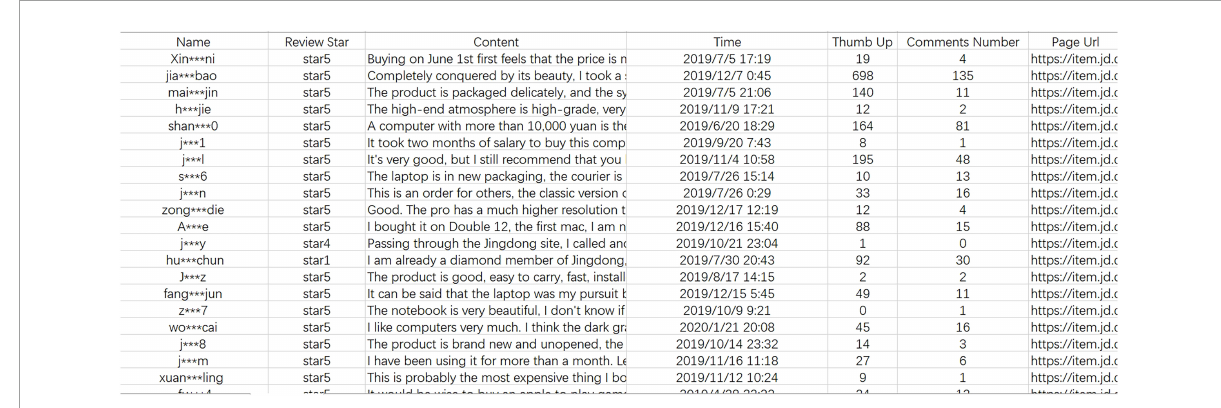
FIGURE1 Crawl results of online review data for four popular laptops on the JD.com (partial).